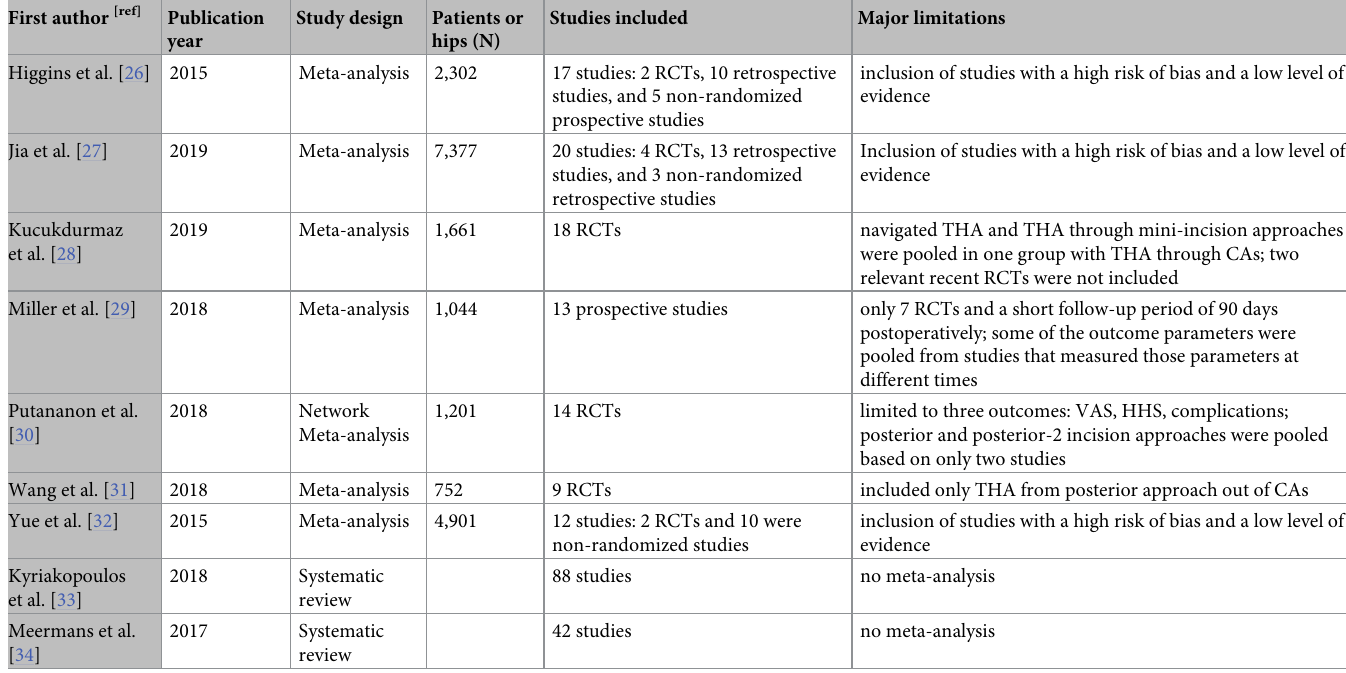
Table 3. Main characteristics of the related systematic reviews and